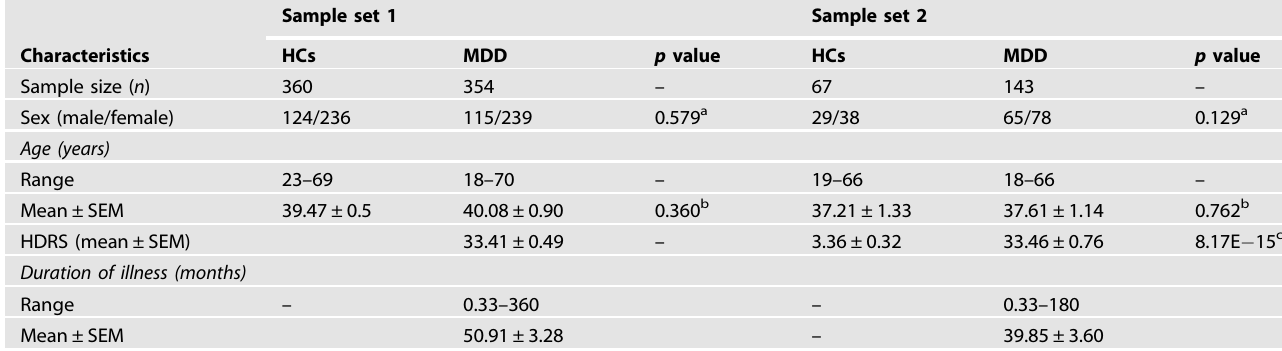
Table 1. Clinical details of recruited subjects in the